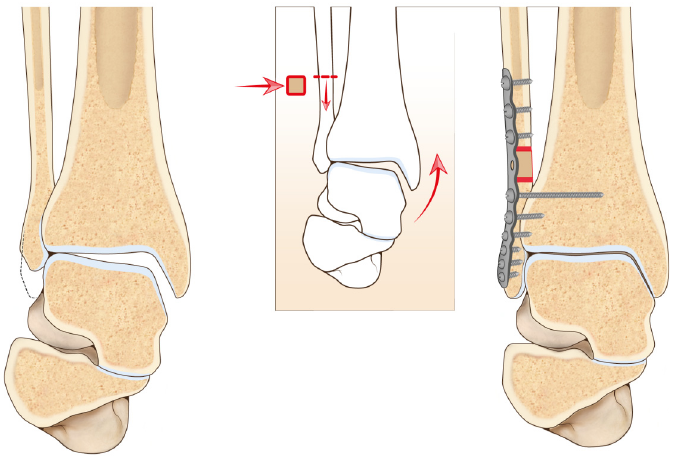
Figure 2. Visual artwork showing fibular lengthening osteotomy technique.